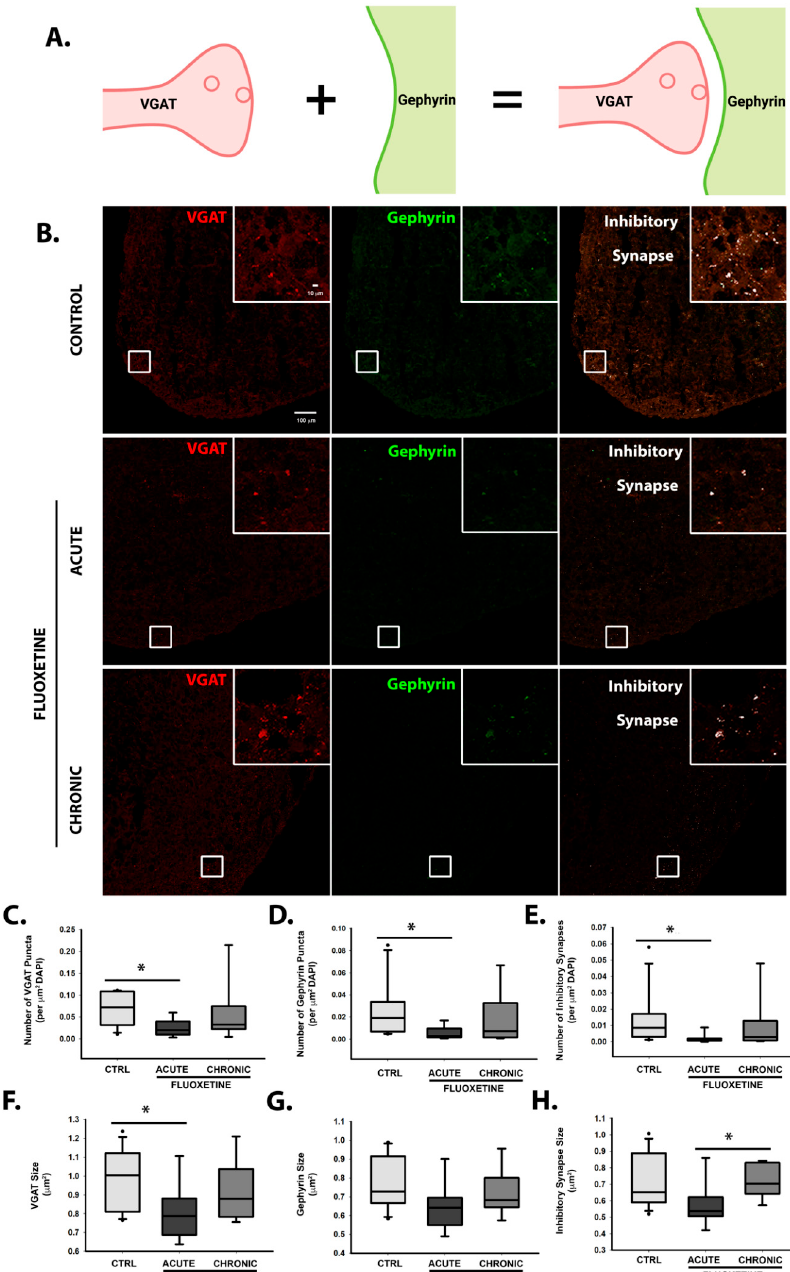
Figure 6. Acute, but not chronic, fluoxetine alters inhibitory synapse formation. ( A ) Schematic of inhibitory pre- (VGAT-positive) and post- (gephyrin-positive) synaptic compartments. Image created using lab-licensed Biorender account. ( B ) 3-month-old cortical spheroids were either acutely or chronically treated with 1.5 µ g/mL fluoxetine. 10 µ m-thick cryosections were immunostained for inhibitory synapse markers, pre-synaptic VGAT (red) and post-synaptic gephyrin (green) and were imaged using confocal microscopy. Scale bar = 10, 100 µ m. ( C – H ) Individual pre- (VGAT+) and post- (gephyrin+) synaptic markers, as well as co-localization between pre- and post-synaptic markers were analyzed to determine the size and density of inhibitory synapses per cryosection. A threshold of 0.001 synapses per µ m 2 DAPI was used for inclusion in the study. n = 12 cryosections from 4 independent cortical spheroid cultures for the untreated control, 9 cryosections from 3 independent cortical spheroid cultures for acute FLX, and 9 cryosections from 3 independent cortical spheroid cultures for chronic FLX. * p < 0.05, One-way